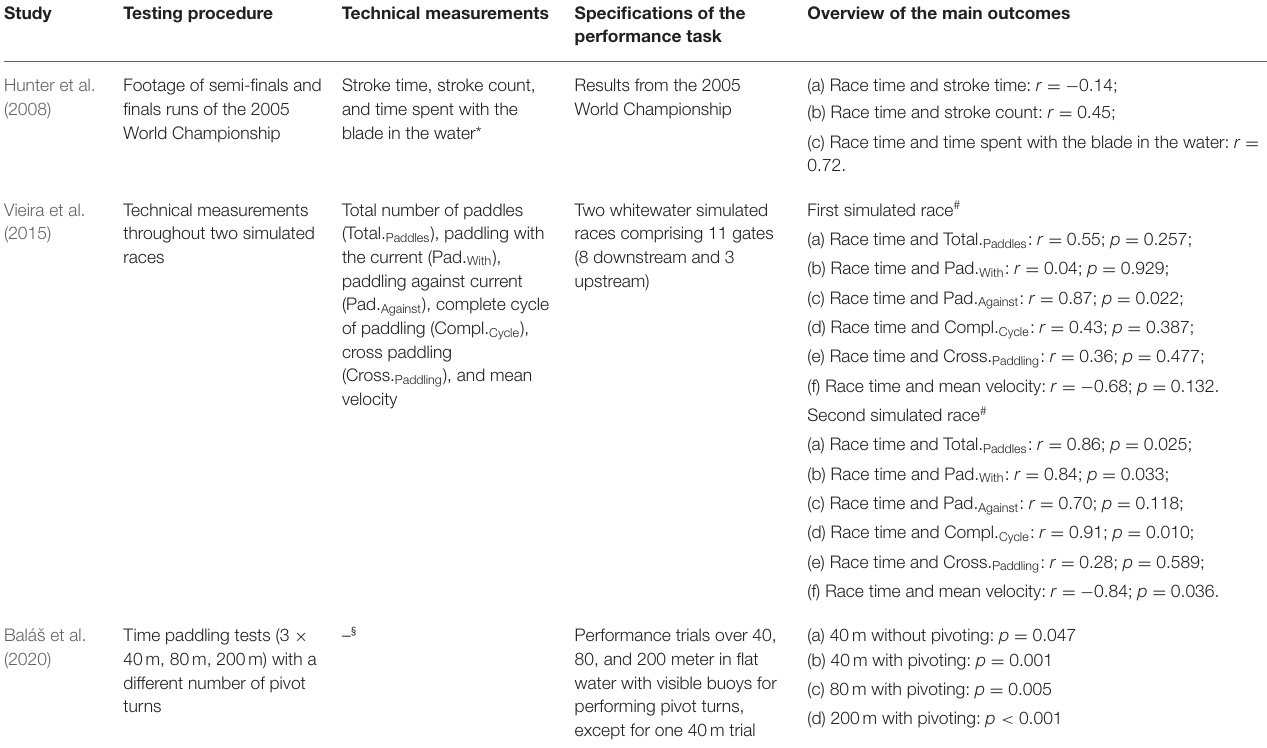
TABLE 4 | Methodological aspects and main results from studies associating the slalom performance with technical